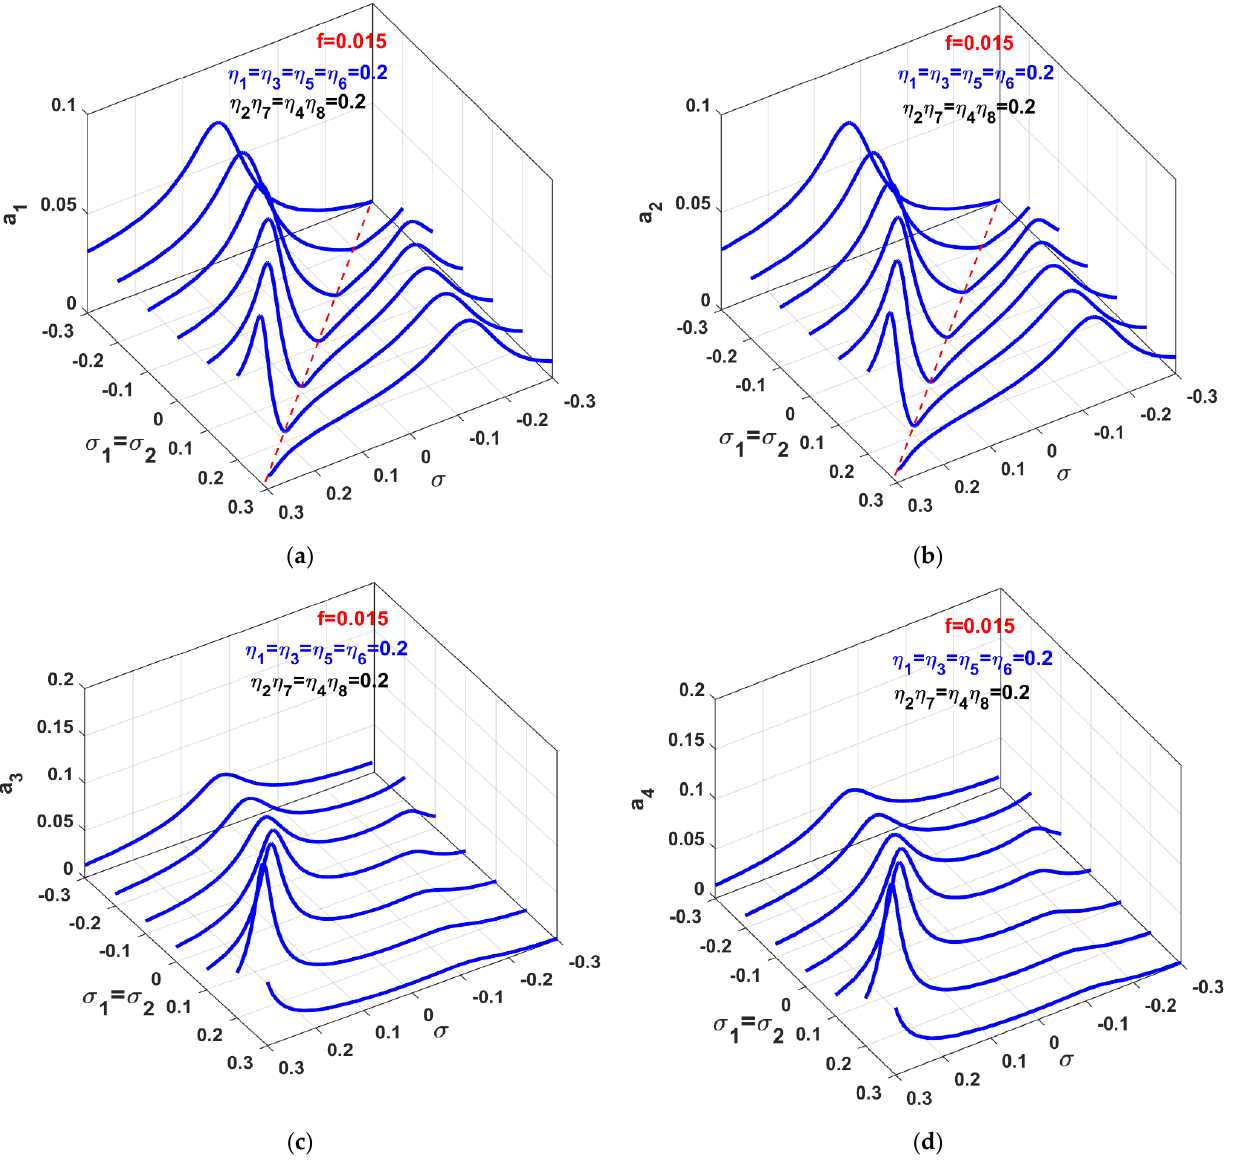
Figure 6. Vibration amplitudes of the rotor system and LIPPF-controller using 𝜎 as a bifurcation parameter at various values of 𝜎 1 = 𝜎 2 when 𝑓 = 0.015 : ( a ) vibration amplitude in 𝑋 1 direction, ( b ) vibration amplitude in 𝑋 2 direction, and ( c , d ) vibration amplitudes of the LIPPF-controller. Based on Figure 6, the detuning parameters 𝜎, 𝜎 1 , and 𝜎 2 were utilized as one bifur- cation parameter via letting 𝜎 = 𝜎 1 = 𝜎 2 as shown in Figure 7, where the oscillation am- plitudes of both the rotor system and the LIPPF-controller were plotted against the bifur- cation parameter 𝜎 = 𝜎 1 = 𝜎 2 at different values of the rotor eccentricity 𝑓 . It is clear from the figure that the rotor oscillation amplitudes ( 𝑎 1 and 𝑎 2 ) were suppressed to very small values along the 𝜎 = 𝜎 1 = 𝜎 2 axis regardless of the magnitude of the rotor eccen- tricity 𝑓 , where the excessive vibration energy of the rotor system was channeled to the LIPPF-controller via the energy bridge that was established between the rotor and the